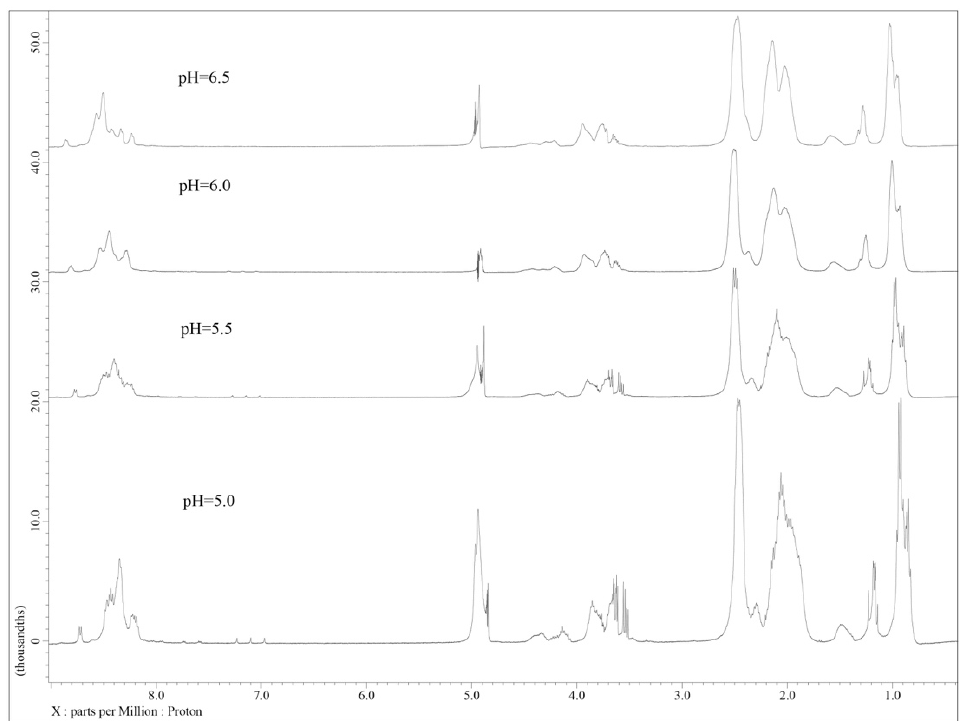
Figure 12. 1 H-NMR spectra of the poly-E peptide at varying pHs, showing increased compaction at lower pHs. Spectra of our 28-amino acid peptide were collected at intervals of 0.5 pH units from pH 5.0 to pH 6.5, which spans the pH range where conformational transitions are observed in both CD and HPLC [25]. As it can be seen, the peaks in the methyl and aliphatic regions of the spectra become sharper, which is consistent with a more compact structure.